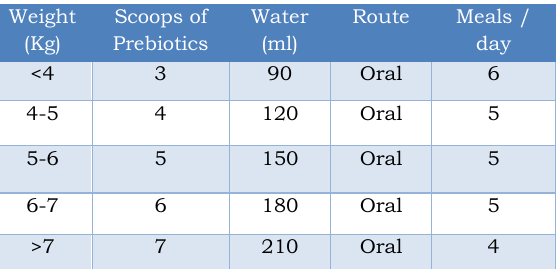
Table 1: The daily dose of the prebiotics Weight Scoops (Kg)